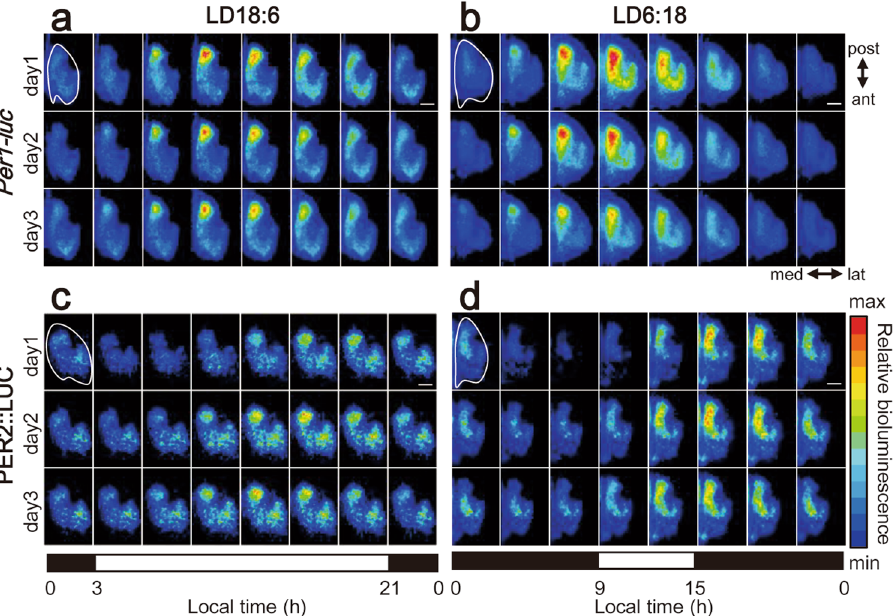
Figure 1. Per-1uc and PER2::LUC bioluminescence throughout the horizontally sectioned SCN slices. ( a , b , c , d ) Representative bioluminescence images of Per1-luc ( a,b ) and PER2::LUC ( c,d ) in the horizontally sectioned SCN slices of mice exposed to LD18:6 (left) or LD8:6 (right). The right SCN slices are illustrated with pseudocolor at every 3 h intervals on day 1, 2 and 3 in culture. A color bar in the right margin indicates relative strengths of bioluminescence. A white trace line in the top left image indicates the margin of the SCN. Scale bar, 50 μ m. The black and white horizontal bars underneath each panel indicate respectively the dark and light phases on the day of tissue